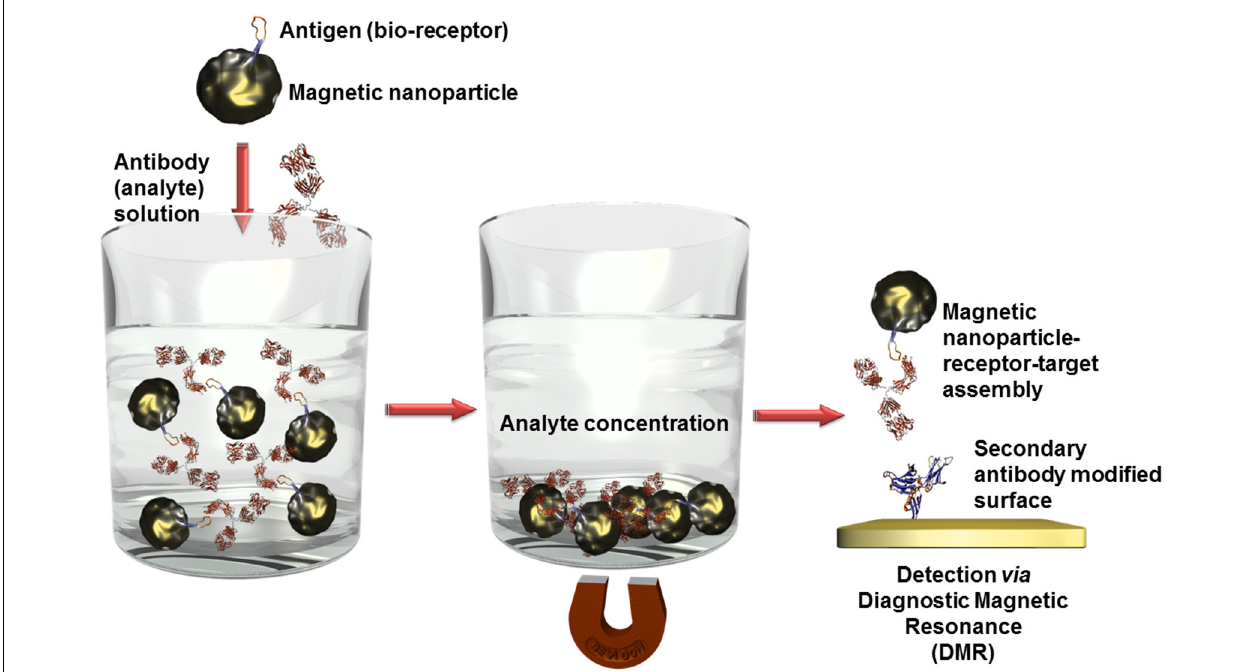
FIGURE 6 | Scheme of analyte concentration in complex solutions via bioreceptor modified magnetic nanoparticles. After the recognition event, the captured analytes can be isolated by precipitation of the magnetic nanoparticles in an external magnetic field. When this magnetic field is